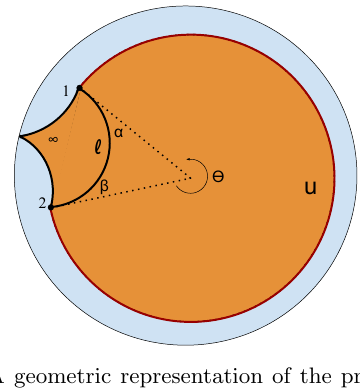
tor. Here we (cid:12)x the span angle (cid:18) , the propagator is a summation over such geometries.